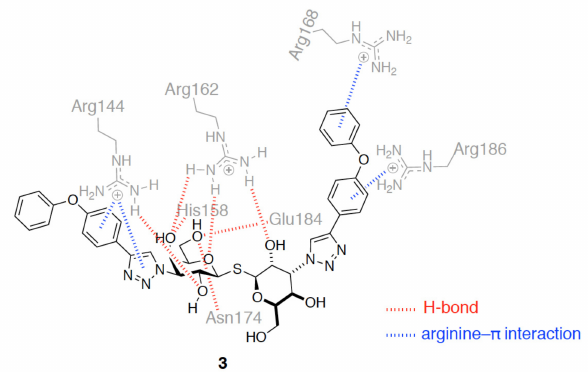
Figure 9. Representative binding mode of compound 3 with GAL-3 that contains H-bonds (shown in red dotted lines) and arginine- π interactions (blue dotted lines). The mentioned binding interactions were derived from the molecular docking